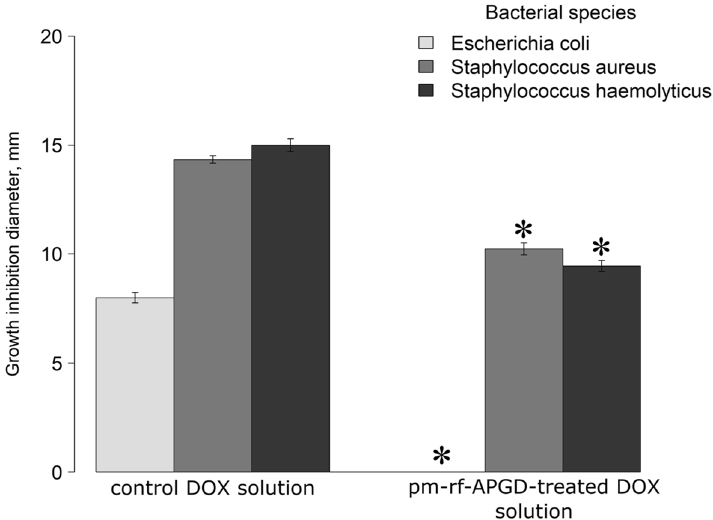
Figure 4. Antibacterial properties of the pm-rf-APGD-treated DOX solution in comparison to the non- plasma-treated control solution. A standard disc-diffusion assay was performed. Means ± standard errors of the measured bacterial growth inhibition diameters are depicted. Asterisks mark statistically significant differences (Welch Two Sample t -test at p < 0.05) between the antimicrobial actions of the CAPP-treated DOX solutions in contrast to the corresponding controls. The experiment was conducted three times with three technical repeats in each. The following bacterial strains were used: E. coli ATCC 25922, S. aureus ATCC 25904, and S. haemolyticus ATCC 29970. DOX – doxycycline. pm-rf-APGD – pulse-modulated radio-frequency atmospheric pressure glow